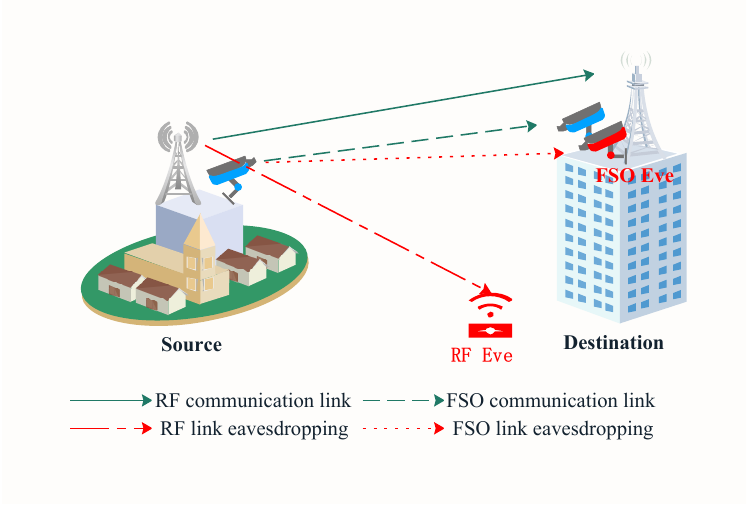
Figure 1. Hybrid FSO/RF system model with RF or FSO link